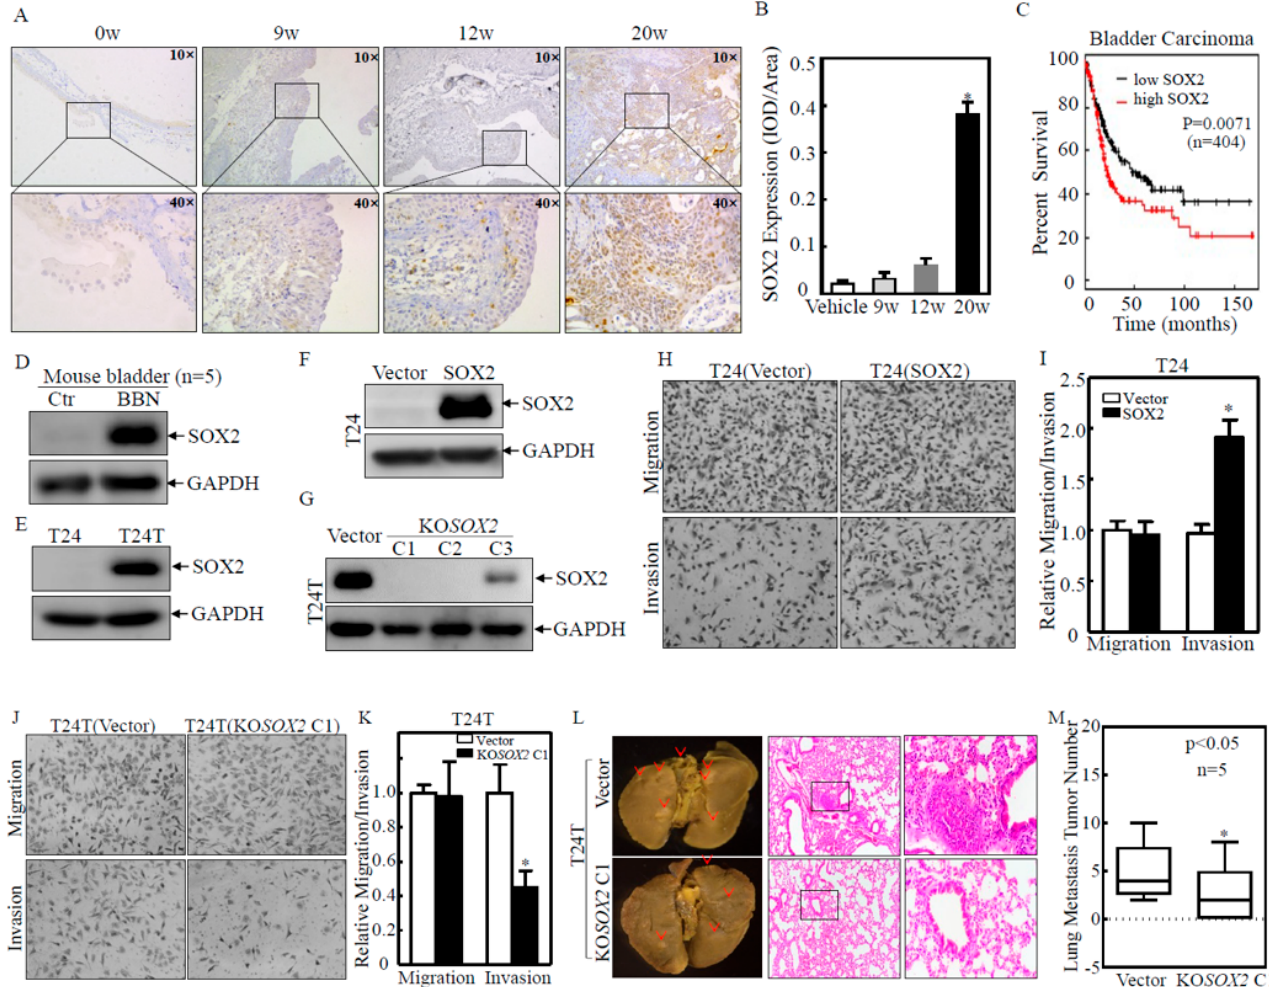
Figure 1. SOX2 was upregulated in mouse and human BC tissues and was critical for BC cell invasion in vitro and nude mouse lung metastasis in vivo. ( A , B ) Mouse bladder tissues ( n = 15) with BBN treatment for a different time were collected for IHC staining to evaluate SOX2 protein expression. The representative images of each tissue were captured as described in the “Materials and Methods” section. SOX2 protein expression levels were analyzed by calculating the integrated IOD/area using Image-Pro Plus version 6.0 (Media Cybernetics, Rockville, USA). The results for each group were expressed as mean ± SD. Symbol (*) indicates a significant difference between the vehicle control group and the BBN-treated 20 weeks group ( p < 0.05). ( C ) Kaplan–Meier estimation of SOX2 levels related to overall survival (OS) in BC patients from the TCGA Database. ( D , E ) Western blot was used to assess the expression of SOX2 in mouse bladder tissues with BBN treatment (Combined equal aliquots of bladder tissue from five mice) ( D ), human BC cells ( E ). ( F , G ) Western blot was used to evaluate SOX2 expression in the stable transfectants of SOX2 overexpression ( F ) or SOX2 knockout ( G ) in BC cells. ( H – K ) The invasion abilities were evaluated in SOX2 stable overexpression transfectants T24(SOX2) or SOX2 stable knockout transfectants T24T(KO SOX2 , clone1), as well as their corresponding vector control transfectants, by using BD BioCoat TM Matrigel TM Invasion Chamber (BD, Bedford, MA, USA). The asterisk (*) indicates a significant difference in invasion ability in comparison to their corresponding vector control transfectants ( p < 0.05). The bars are presented as the mean ± SD from three independent experiments. ( L , M ) T24T(KO SOX2 C1), and its vector